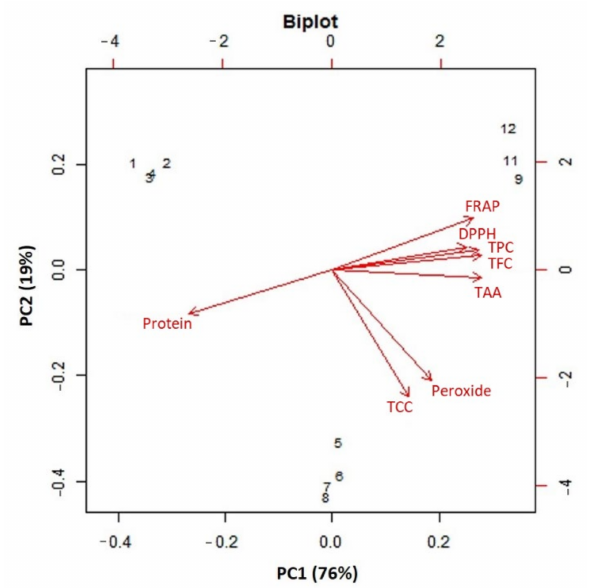
Figure 7. Principal component plot derived from various antioxidant activities [(1,1-diphenyl-2- picrylhydrazyl (DPPH), ferric-reducing antioxidant power (FRAP), peroxide, total carotenoid content (TCC), and total ascorbic acid (TAA)], protein, TPC, and TFC in the lentil